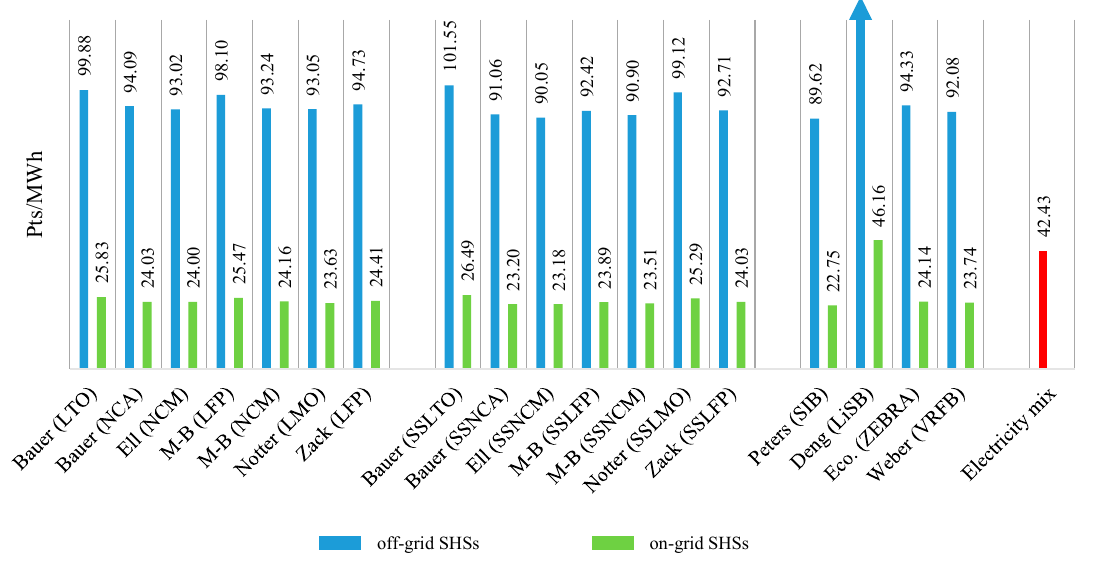
Figure 5. LCA impact values of SHSs in Denmark as single scores.